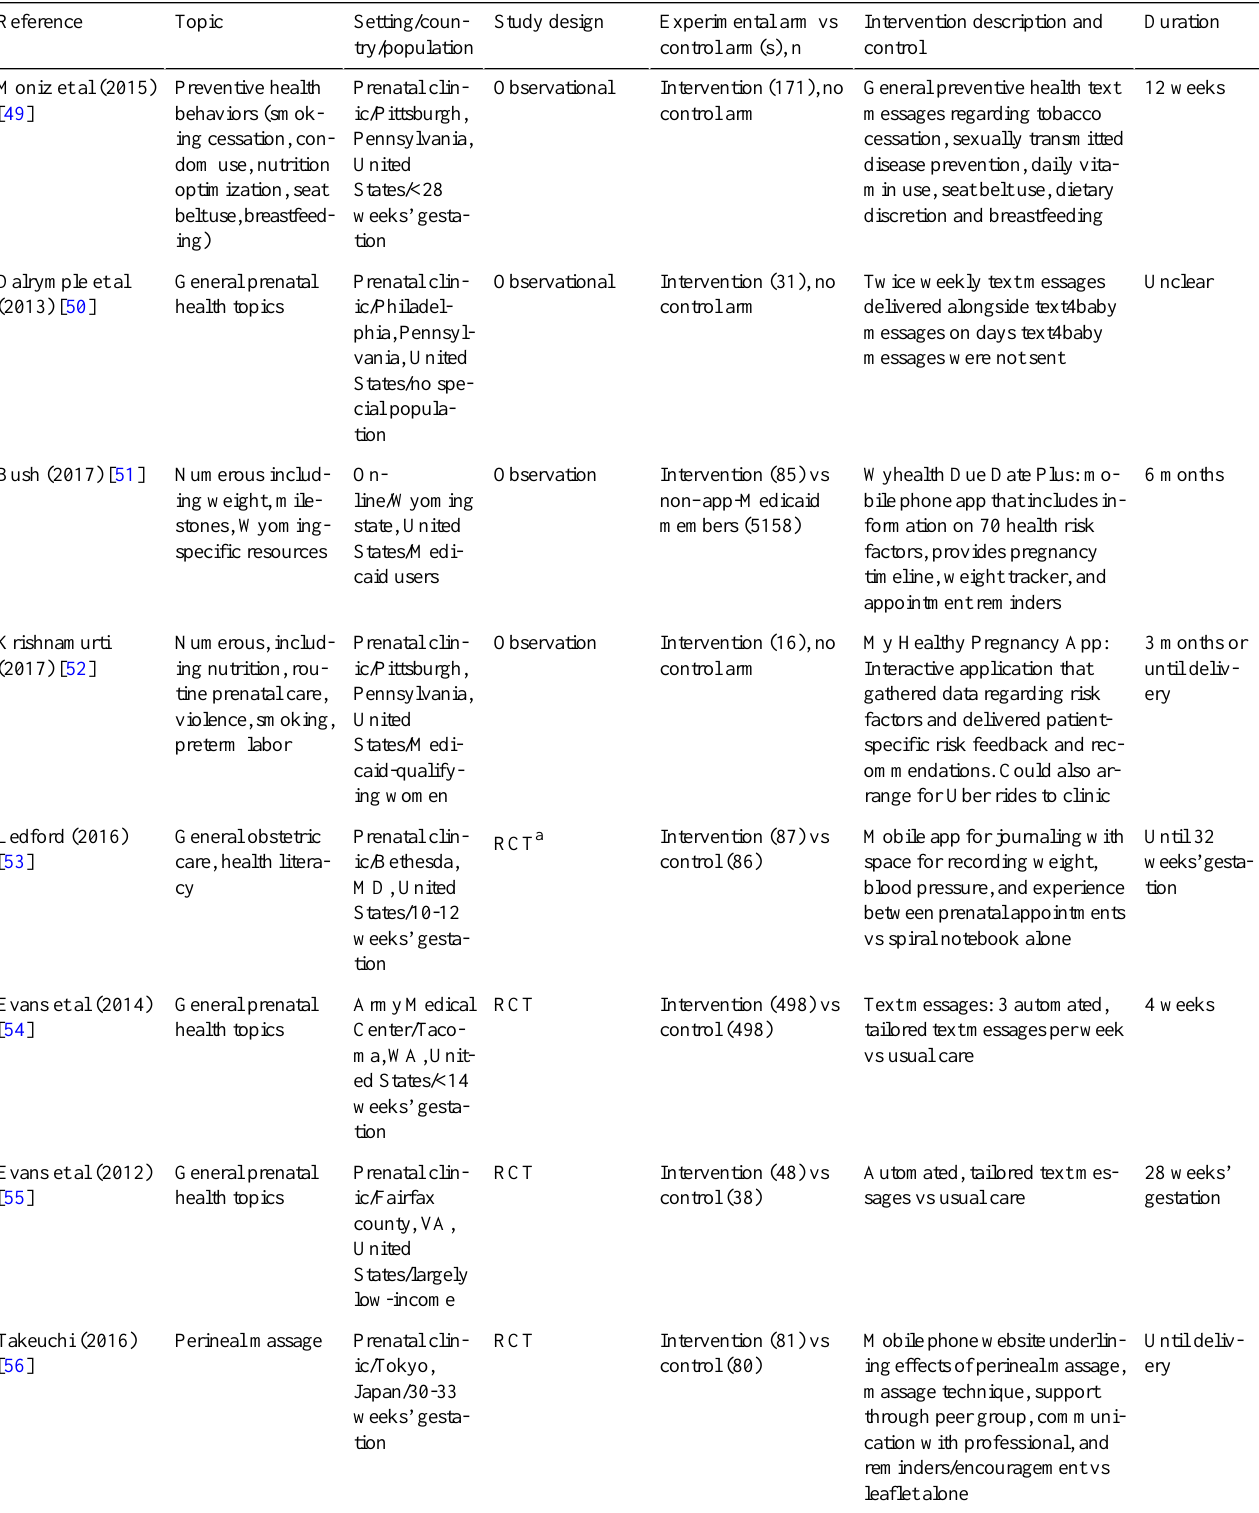
Table 7. Design of trials with a focus on general health, preventive health, health beliefs, and other